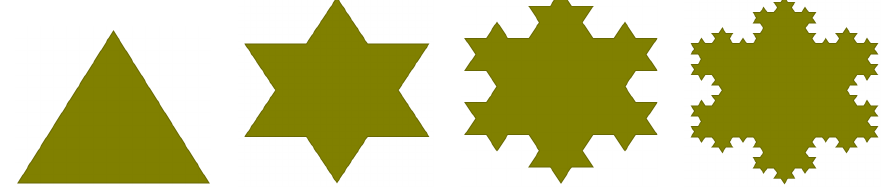
Figure 19. Four stages of the Snowflake fractal.